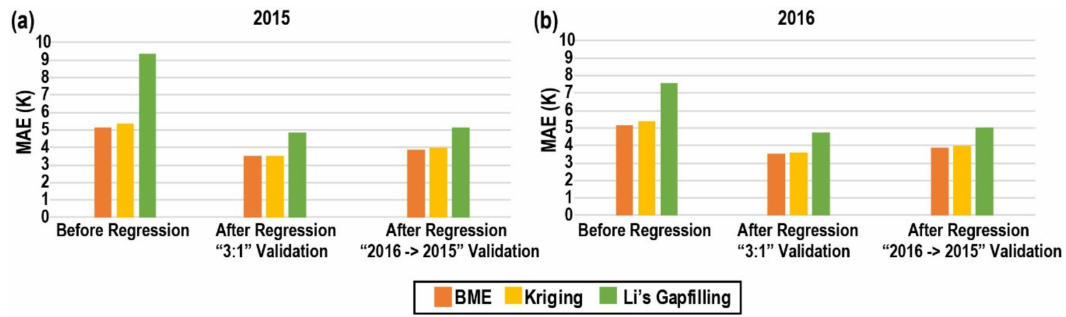
Figure 7. Comparison of the influence of three di ff erent clear-sky LST reconstruction methods on the accuracy of regression cloudy-sky LST in 2015 ( a ) and in 2016 ( b ).